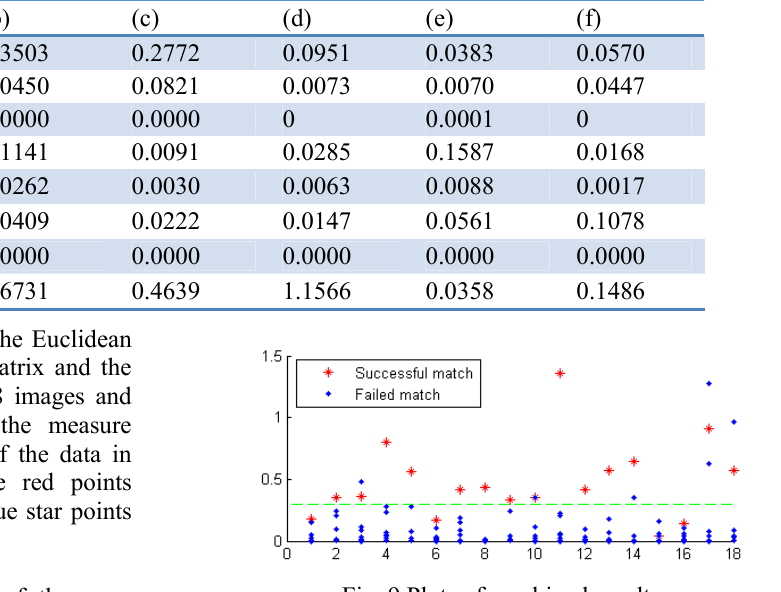
Fig. 9 Plots of combined result